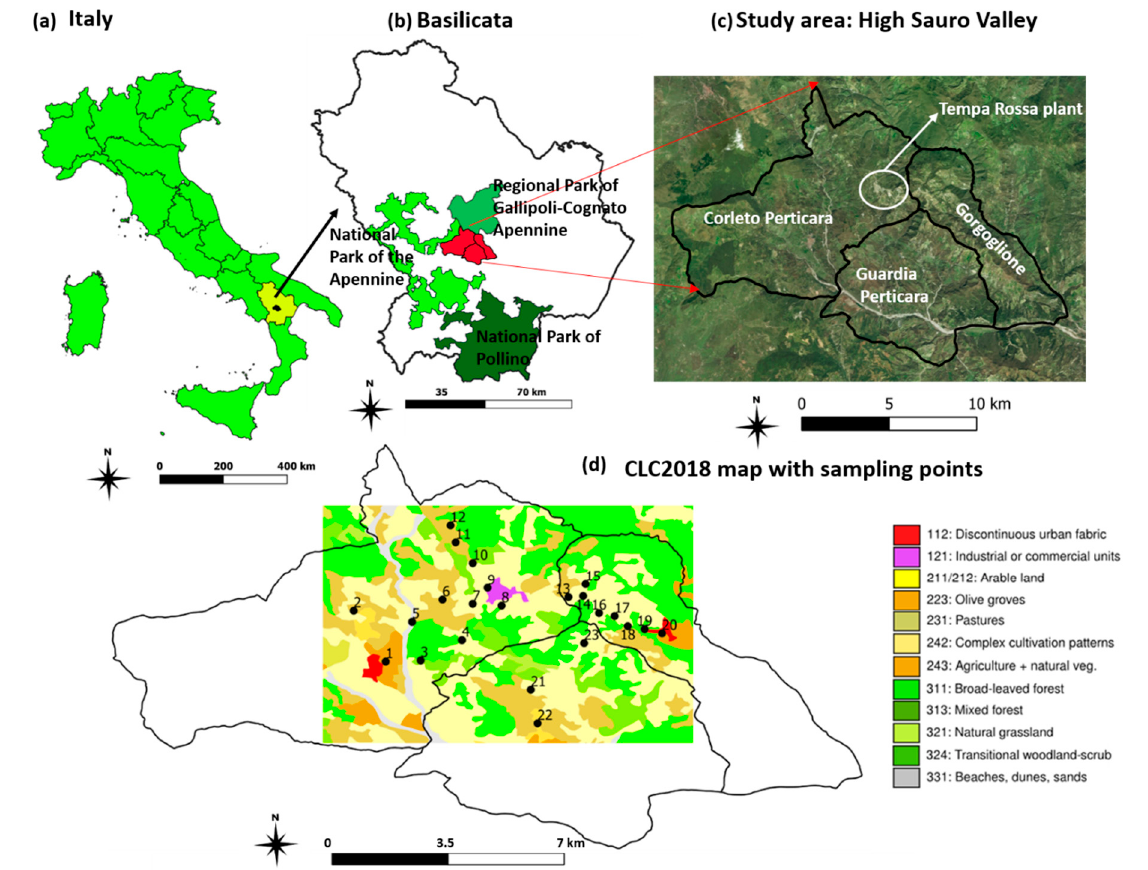
Figure 1. The High Sauro Valley ( c ) located in Basilicata ( b ), a region of Southern Italy ( a ), that includes, among others, the municipalities of Gorgoglione, Guardia Perticara and Corleto Perticara, where the Tempa Rossa plant has been built. ( d ) The Corine Land Cover 2018 (CLC2018) was used as the main map to identify the different land covers of the investigated area, falling prevalently within the three mentioned municipalities. The numbers 1–23 represent the sampling points.